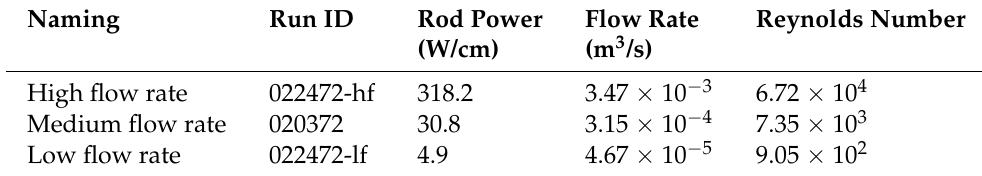
Figure 6. Example of simulation results for the high-flow test case in the ORNL’s 19-pin benchmark. ( a ) Distribution of axial mass flow. ( b ) Distribution of lateral mass flow. ( c ) Distribution of temperature. ( d ) Distribution of temperature-dependent dynamic viscosity. Table 4. Validation cases selected in the ORNL